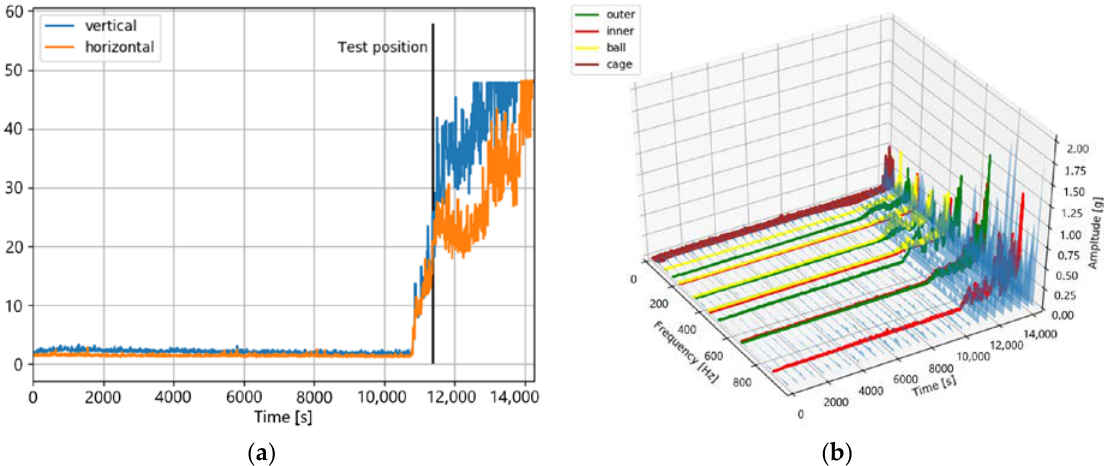
Figure 12. The sensor values of bearing dataset 1_4 in the time domain ( a ) and in the time–frequency domain ( b ). Both figures show increased amplitudes at the test position.